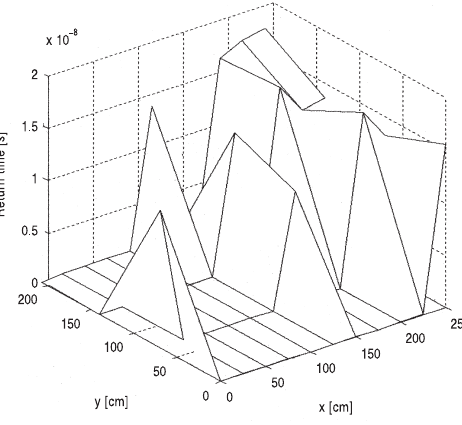
Fig. 11. Prospecting in linear common offset on a buried Roman road.